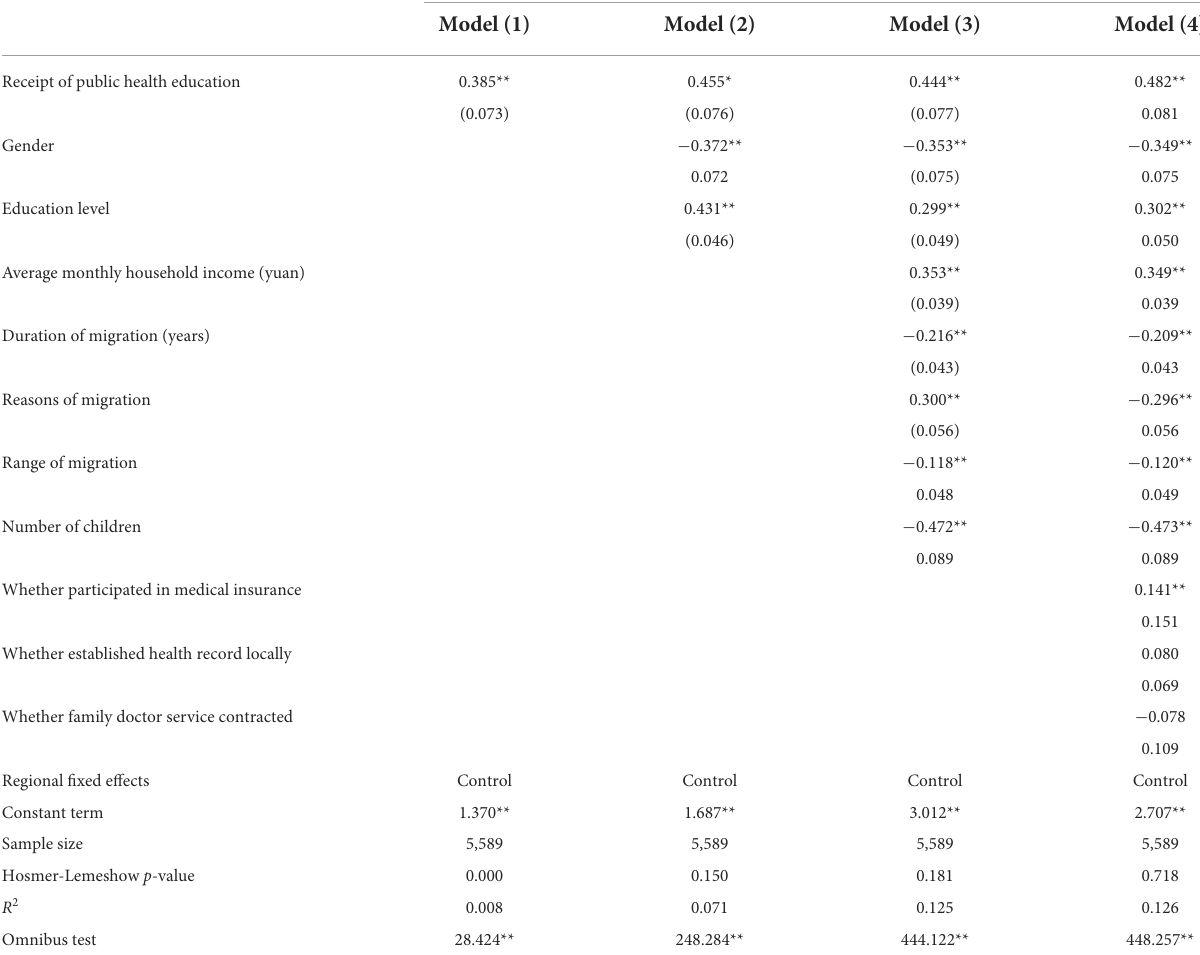
TABLE 2 Impact of receiving public health education on the health of the older migrant population.